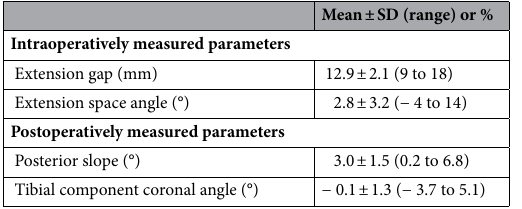
Table 2. Intraoperatively and postoperatively measured parameters. SD standard deviation.